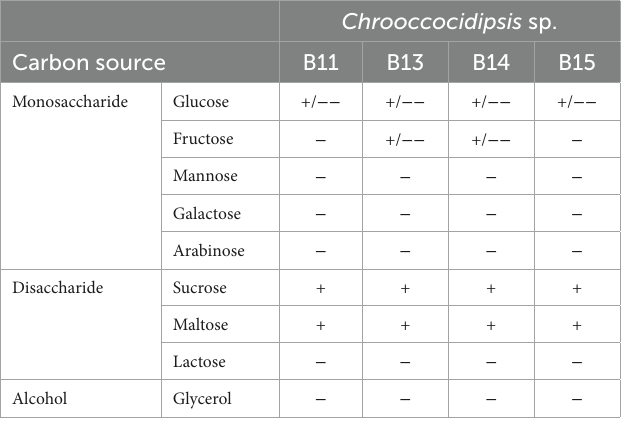
TABLE 3 Heterotrophic growth of Chroococcidiopsis isolates. Chrooccocidipsis sp.